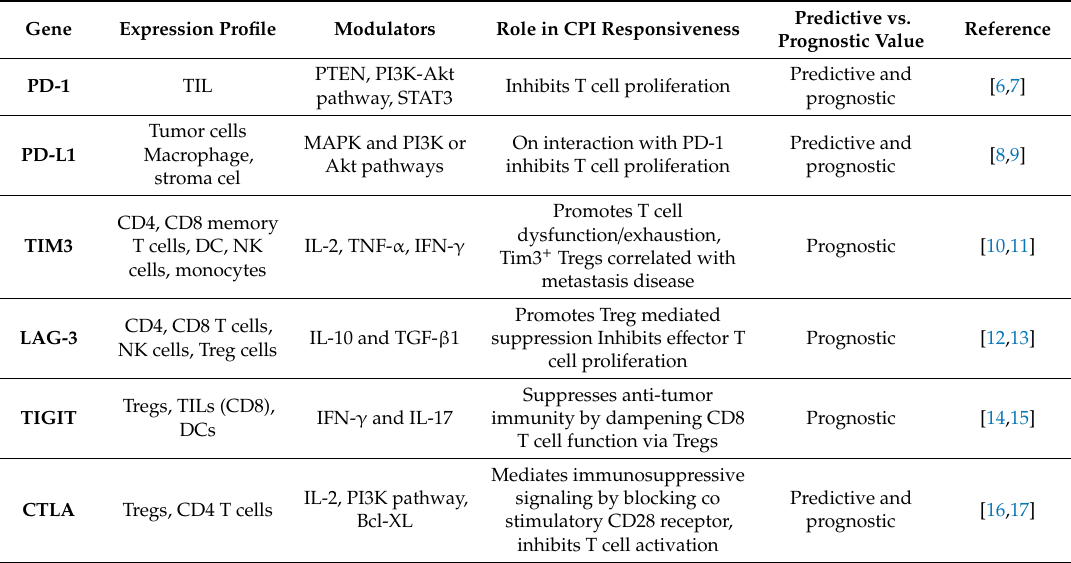
Table 1. Key genes involved in checkpoint blockade immunotherapy (CPI)